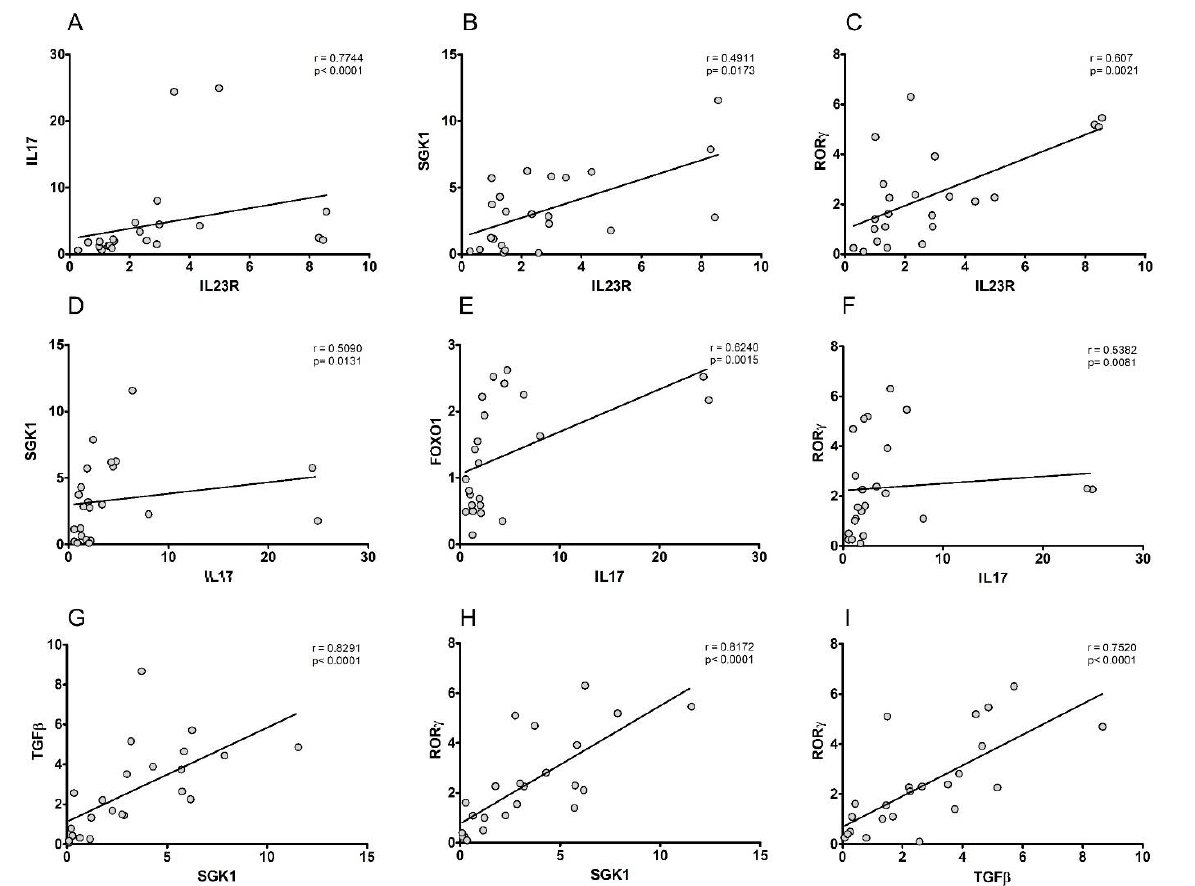
Figure 3. A Spearman correlation analysis on the PBMCs’ gene expression in the overall study subjects ( n = 23). Data plotted as a fold expression revealed significant positive correlations between IL23R and IL17A ( A ), SGK1 ( B ), RORG ( C ), between IL17A and SGK1 ( D ), FOXO1 ( E ), RORG ( F ), between SGK1 and TGFB ( G ), RORG ( H ), and between TGFB and RORG ( I ). The Spearman rank coefficient (r) and the p value are indicated at the top of each graph.